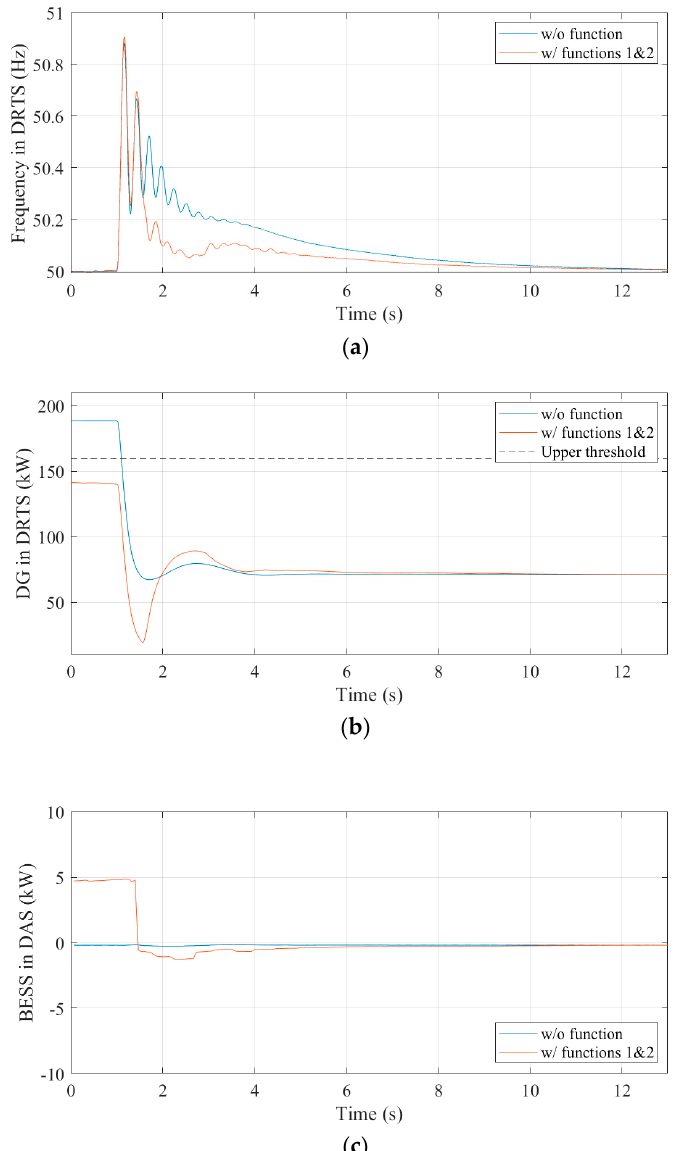
Figure 9. Test results when functions 1 and 2 are activated (load reduction from 19 kW to 7 kW): ( a ) frequency; ( b ) DG set output; ( c ) battery output. Note that 10 times scaled measurement of